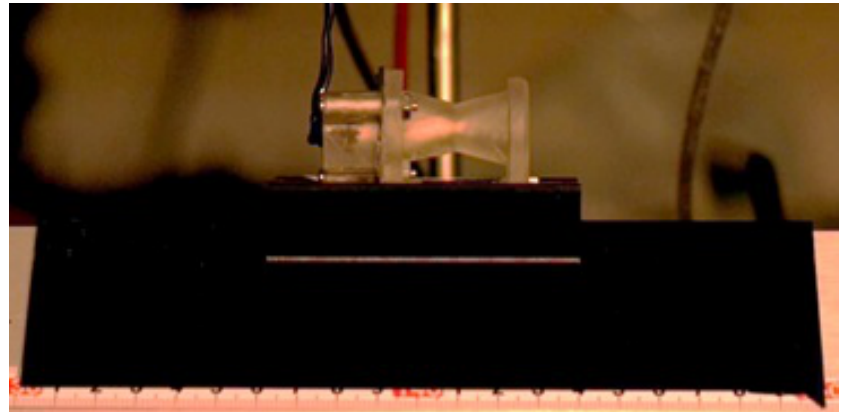
Figure 8. A photograph of the prototype thruster in testing configuration on an air